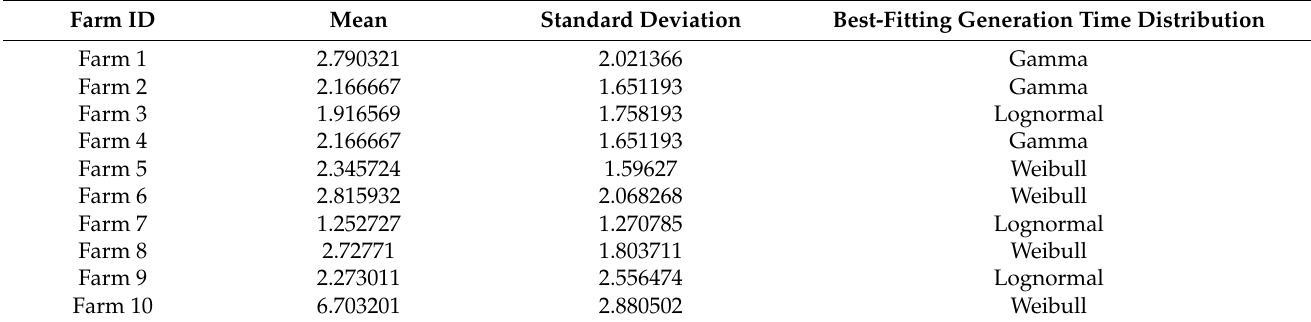
Table 2. Model fitting results for a serial interval of each farm.